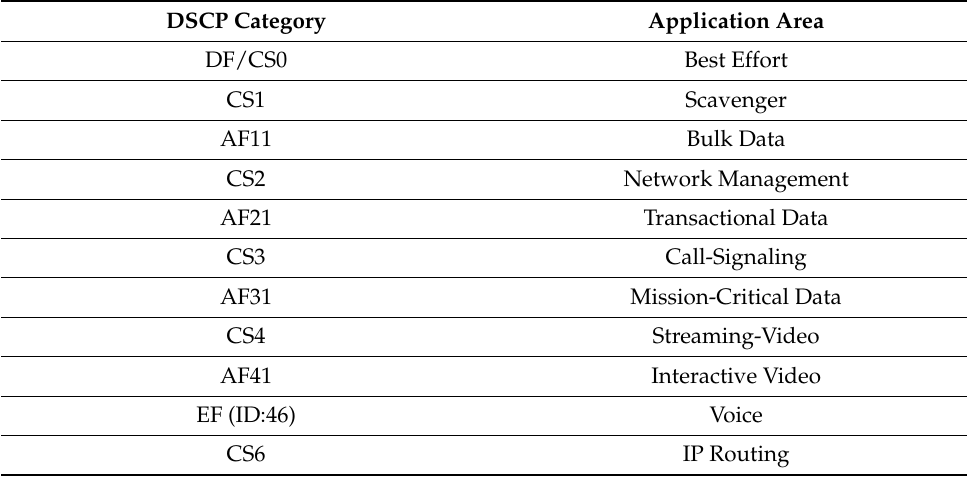
Table 3. Cisco’s QoS Baseline